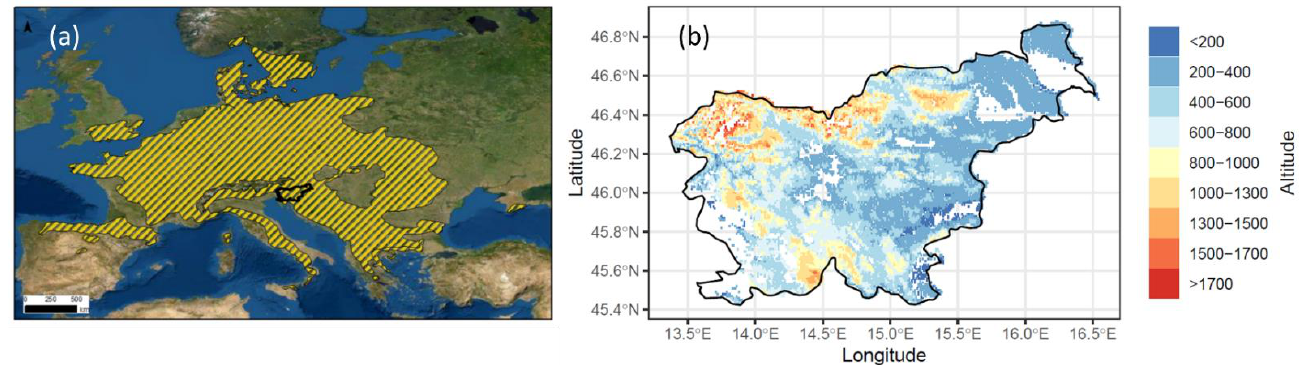
Figure 1. ( a ) Natural range of Fagus sylvatica in Europe, with the location of Slovenia marked in black [8,9]; ( b ) natural range of Fagus sylvatica across altitudinal gradient (m a.s.l.) in Slovenia [10]. White areas represent forest stands without Fagus sylvatica .